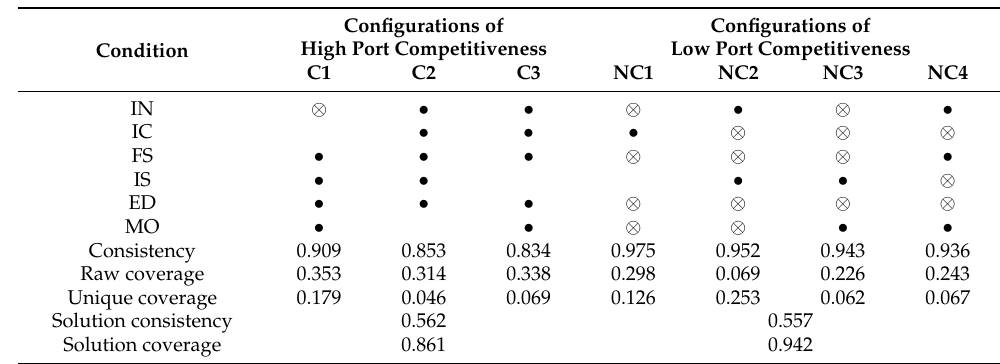
Table 6. Configurations of port competitiveness. • indicates the presence of the core condition, • indicates the presence of the edge condition, ⊗ indicates the absence of the core condition, ⊗ indicates the absence of the edge condition, and a blank indicates that the presence or absence of the condition was insignificant for the